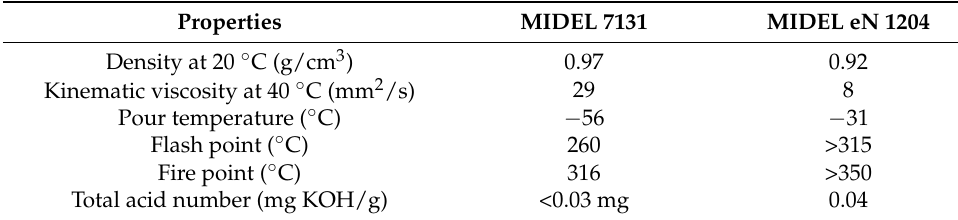
Table 1. The physicochemical properties of the base fluids [5,16].